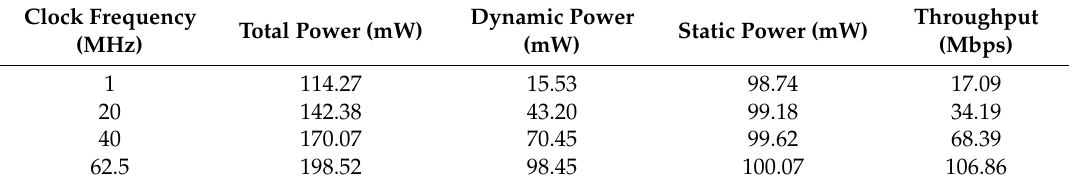
Table 5. Power consumption and throughput performance of compression hardware